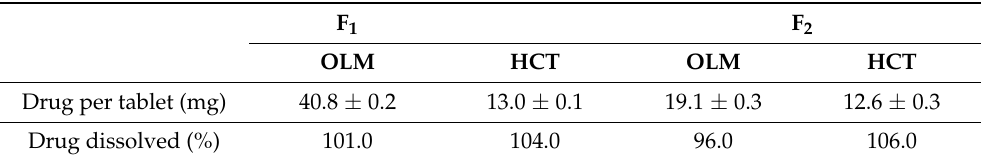
Table 4. Results of color stability (MCDM, ∆E00) at 0 and 24 months for two different formulations, F 1 and F 2.